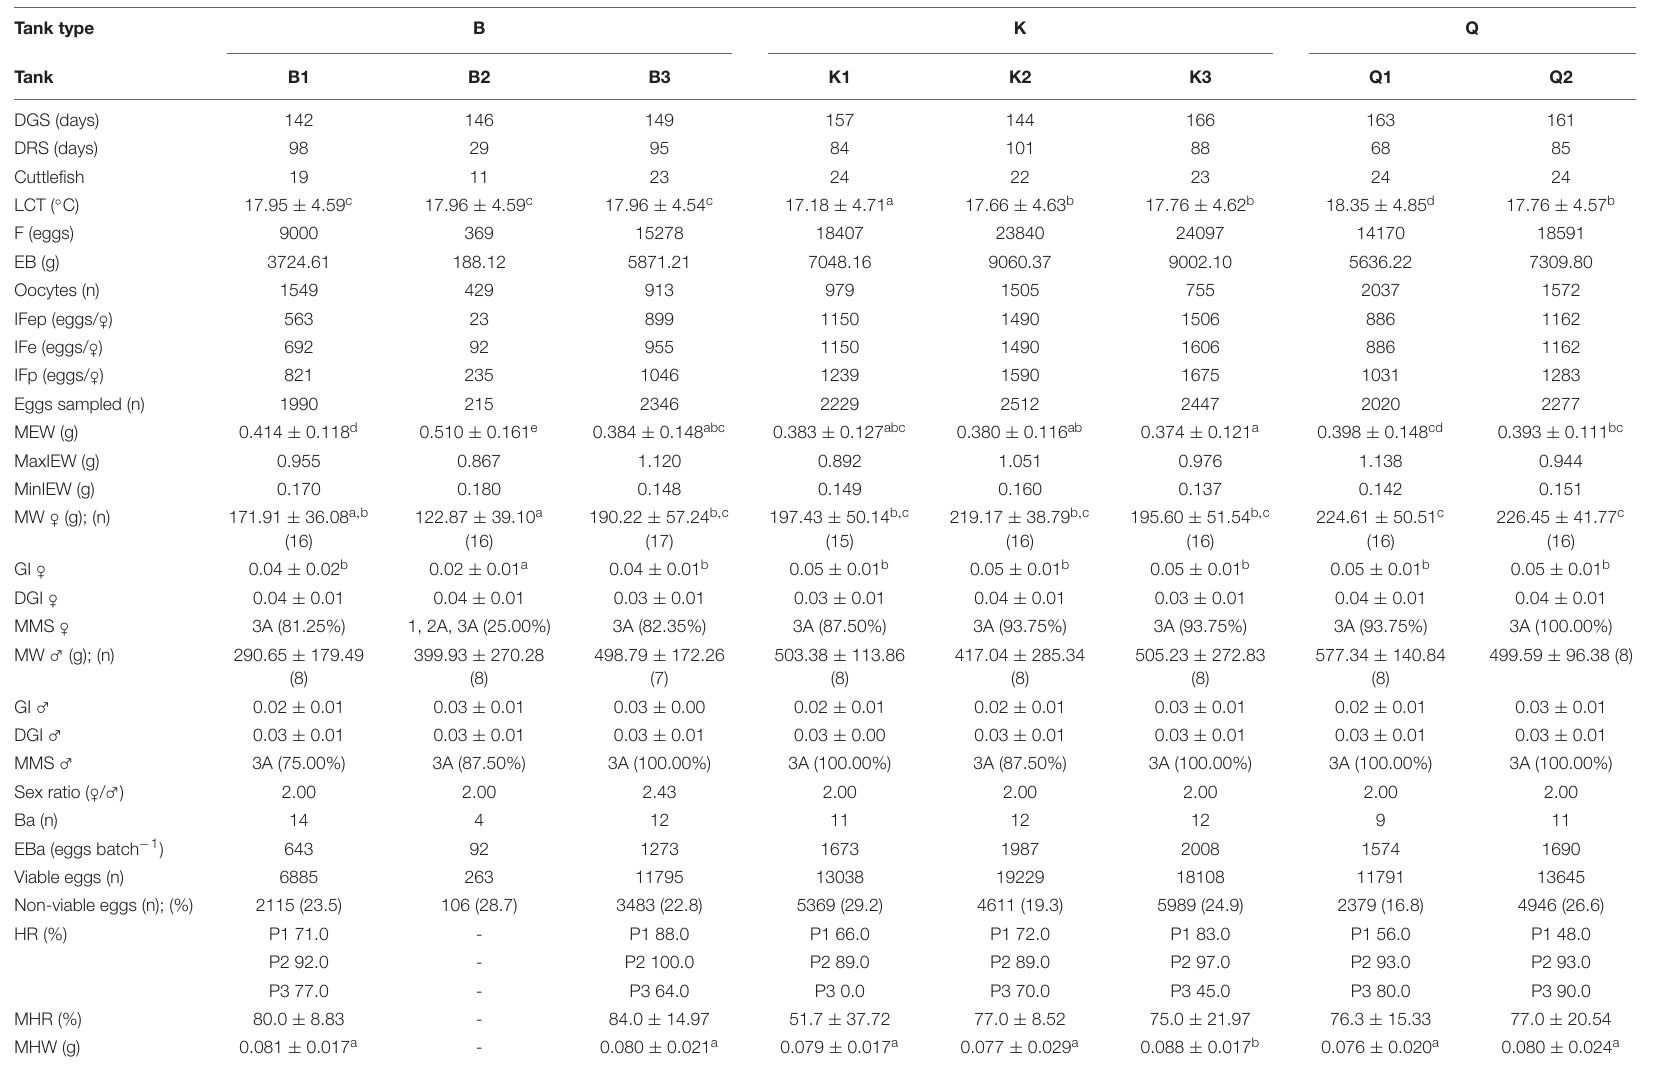
TABLE 3 | Duration of Growth and Reproduction Stages (DGS and DRS), Cuttlefish (available animals at the start of the reproduction stage), Life Cycle Temperature (LCT), Fecundity (F), Egg Biomass (EB), Oocytes, Individual Expected Fecundity (IFep), Individual Effective Fecundity (IFe), Individual Potential Fecundity (IFp), Eggs Sampled, Mean Egg Weight (MEW), Maximum and Minimum Individual Egg Weight (MaxIEW and MinIEW, respectively), Mean Female and Male Weight (MW respectively), Mean Female and Male Maturation Stage [MMS Rate (HR), Mean Hatching Rate (MHR), Mean Hatchling Weight (MHW), Food Supplied (FS), Food Cost per tank (FC), Individual Cuttlefish Cost per tank (ICC), Tank Cost per Day (TCD), Egg Cost (EC) values and Viable Egg Cost (VEC); for cuttlefish at the end of reproduction stage.